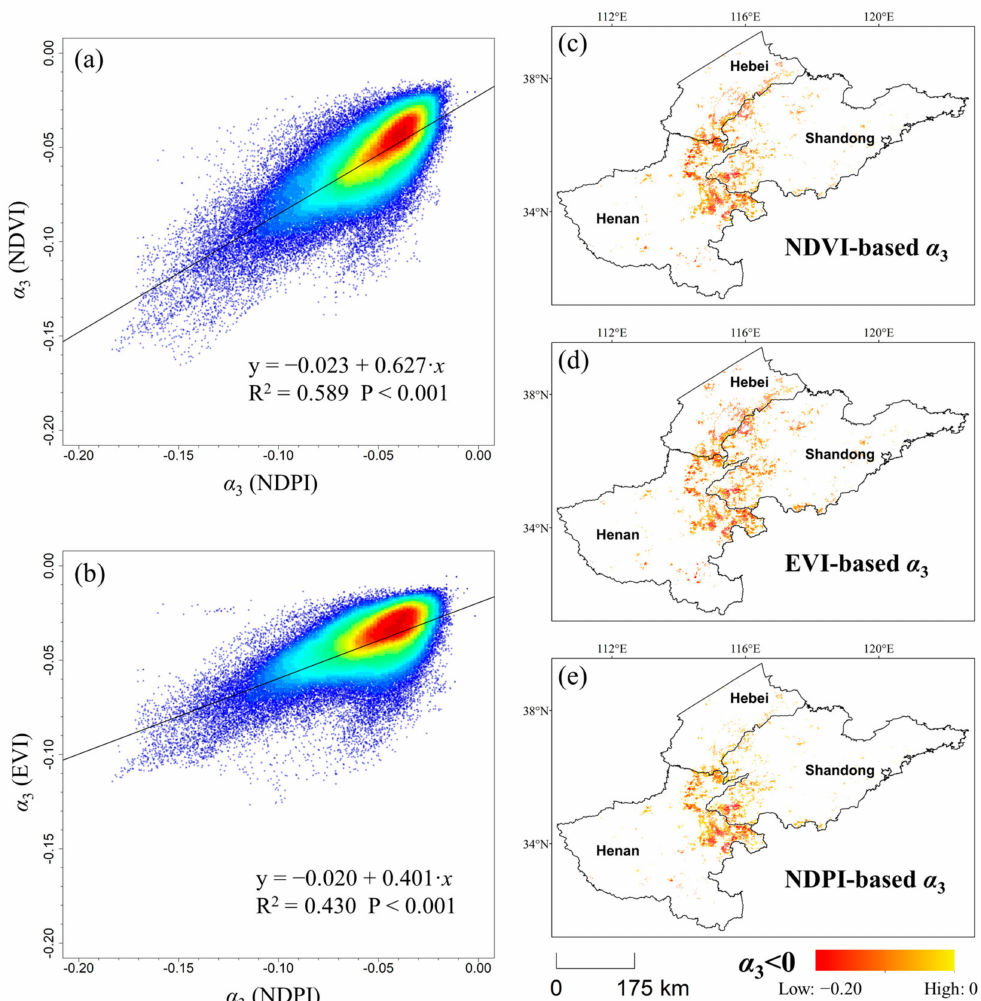
Figure 11. The scatterplots of estimated a 3 using NDVI and EVI against the estimated a 3 using NDPI for the year of 2014 ( a , b ) and the spatial distribution of statistically significant negative a 3 estimation using NDVI ( c ), EVI ( d ), and NDPI ( e